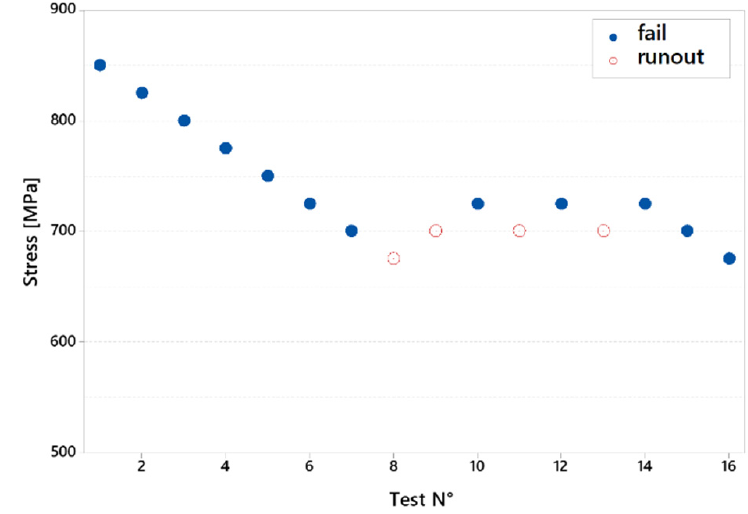
Table 7. Fatigue limits reached by nitrided specimens after staircase fatigue test.